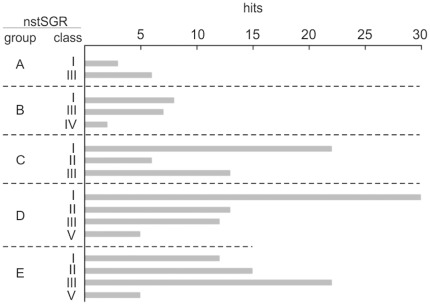
Classes of candidate sRNAs and their distribution within the nstSGR groups resulting from sRNA-Seq.The histogram summarizes the data of Table S2. Candidate sRNAs identified by sRNA-Seq were categorized into five structural/functional classes (I, sRNAs; II, 5′-UTRs; III, asRNAs; IV, CRISPRs; V, sRNAs overlapping annotated ORFs) according to the criteria depicted in Figure S3 and distributed within each nstSGR group (A and B, unique in PAO1 or PA14, respectively; C and E, conserved in both strains but expressed in either PAO1 or PA14, respectively; D, conserved and expressed in both strains).